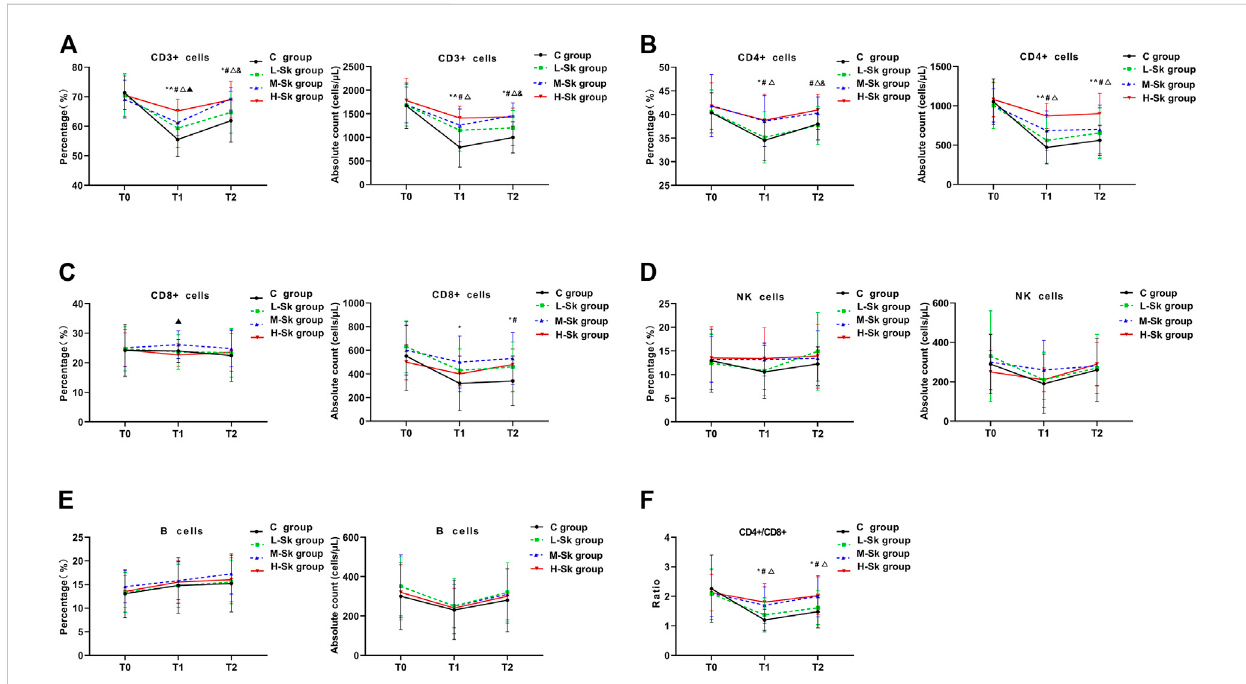
FIGURE 2 Comparison of the percentage and absolute counts of the lymphocyte subsets among the four groups. The cellular immune function variables includeCD3 + cells (A) ,CD4 + cells (B) ,CD8 + cells (C) ,NKcells (D) ,Bcells (E) ,andCD4 + /CD8 + (F) .Valuesrepresenttheestimatedmeansfromlinearmixed modelswiththestandarderror,analyzedusingANOVA forrepeatedmeasures.T0,beforeanesthesia;T1,attheendofsurgery; T2,24 hafterthesurgery; C group, control group; L-Sk group, low-dosage S-ketamine group; M-Sk group, middle-dosage S-ketamine group; H-Sk group, high-dosage S-ketamine group. ^ p < 0.05, the L-Sk vs C groups at the corresponding time point. * p < 0.05, the M-Sk vs C groups at the corresponding time point. # p < 0.05, the H-Sk vs C groups at the corresponding time point. △ p < 0.05, the H-Sk vs L-Sk groups at the corresponding time point. & p < 0.05, the M-Sk vs L-Sk groups at the corresponding time point. ▲ p < 0.05, the H-Sk vs M-Sk groups at the corresponding time